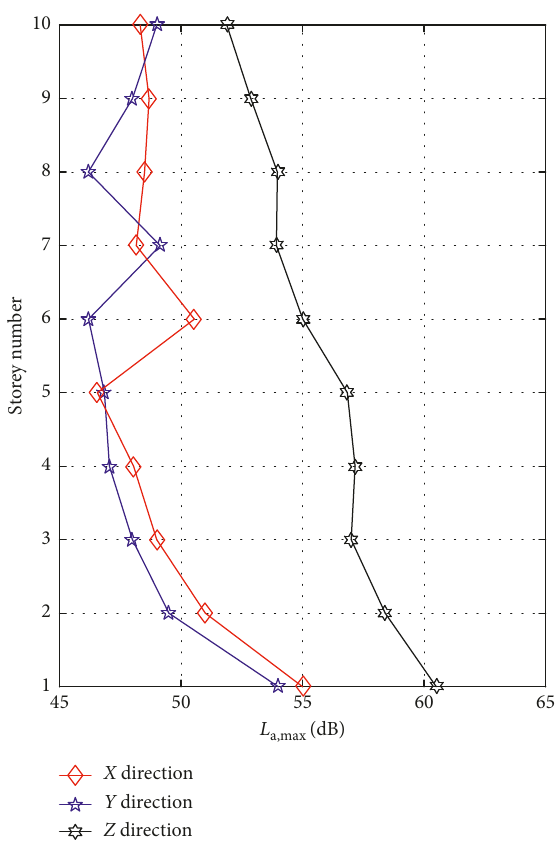
Figure 18: The distribution of maximum frequency acceleration level along the high-wise (damping ratio